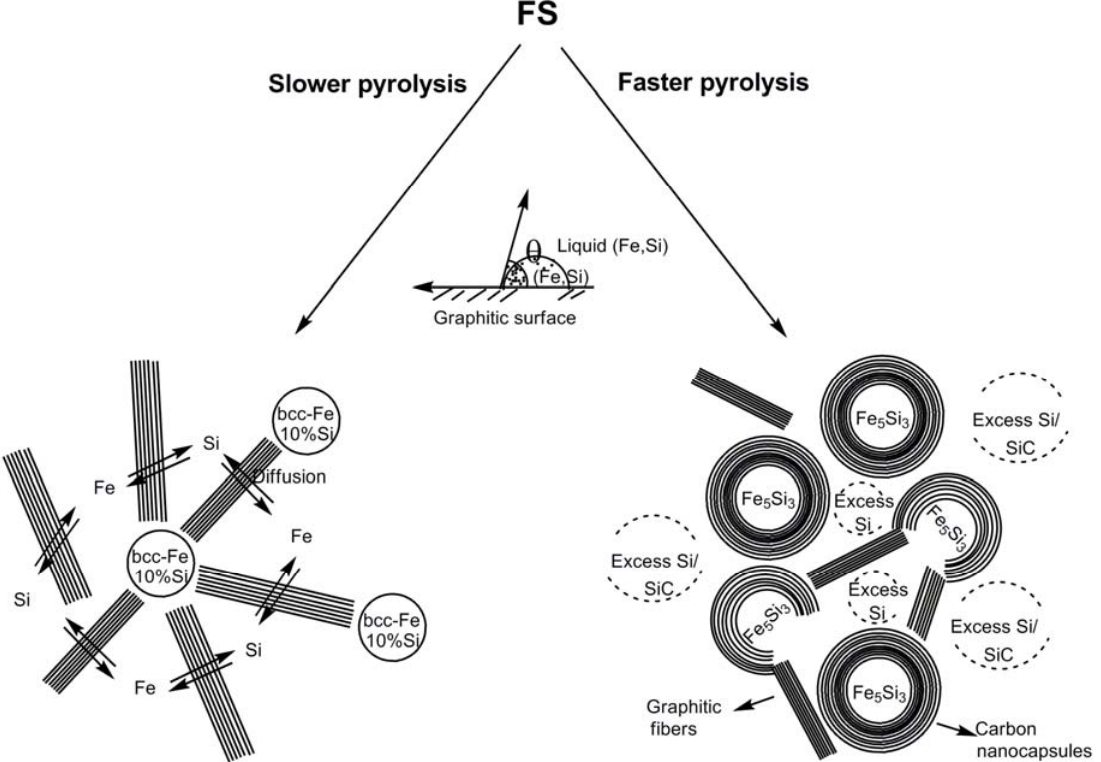
Scheme 1. Representation of pathways to form nanoparticles of silicon-doped bcc-Fe and Si , respectively, at slower and faster pyrolysis rates. Adapted from Ref. [8] with Fe 5 3 permission from American Chemical